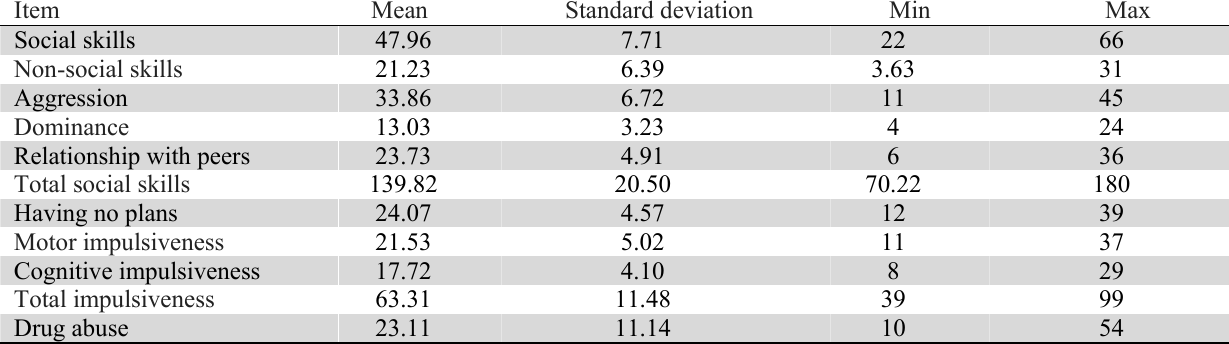
Basic statistics associated with different components of the questionnaire Item Mean